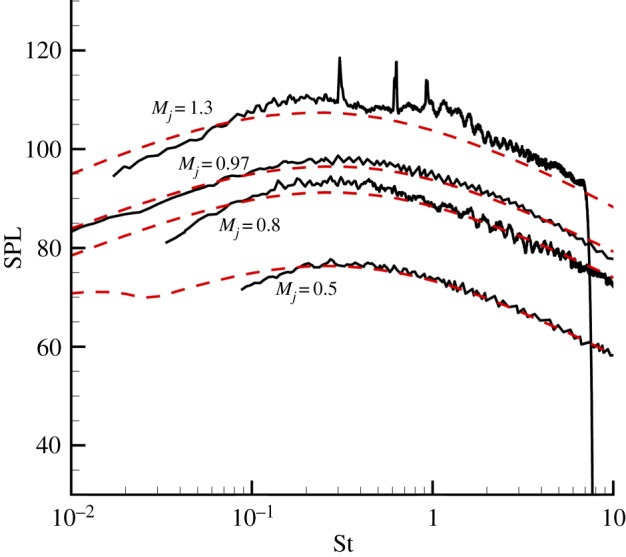
Comparison of spectra at 60° to the jet axis and R = 100D. (Online version in colour.)